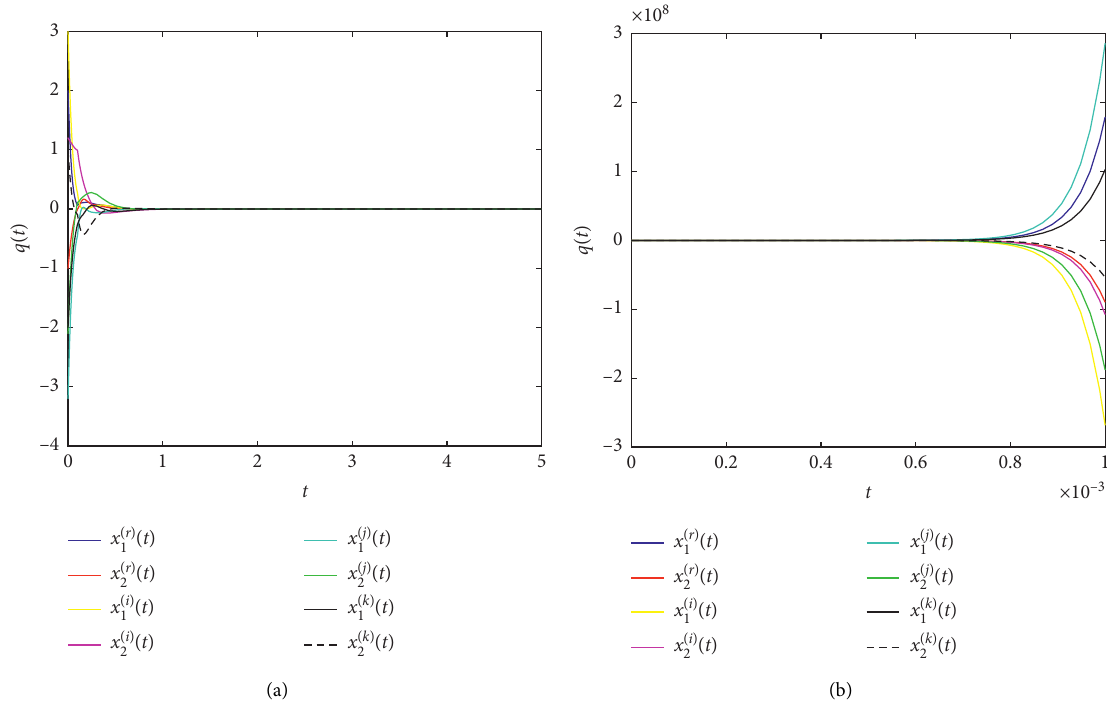
Figure 3: The state trajectories of x ( r ) ( t ) ,x ( i ) ( t ) ,x ( j ) ( t ) , and x ( k ) ( t ) of QVVNs model (34). (a) With I(t) � 0. (b) Under controller